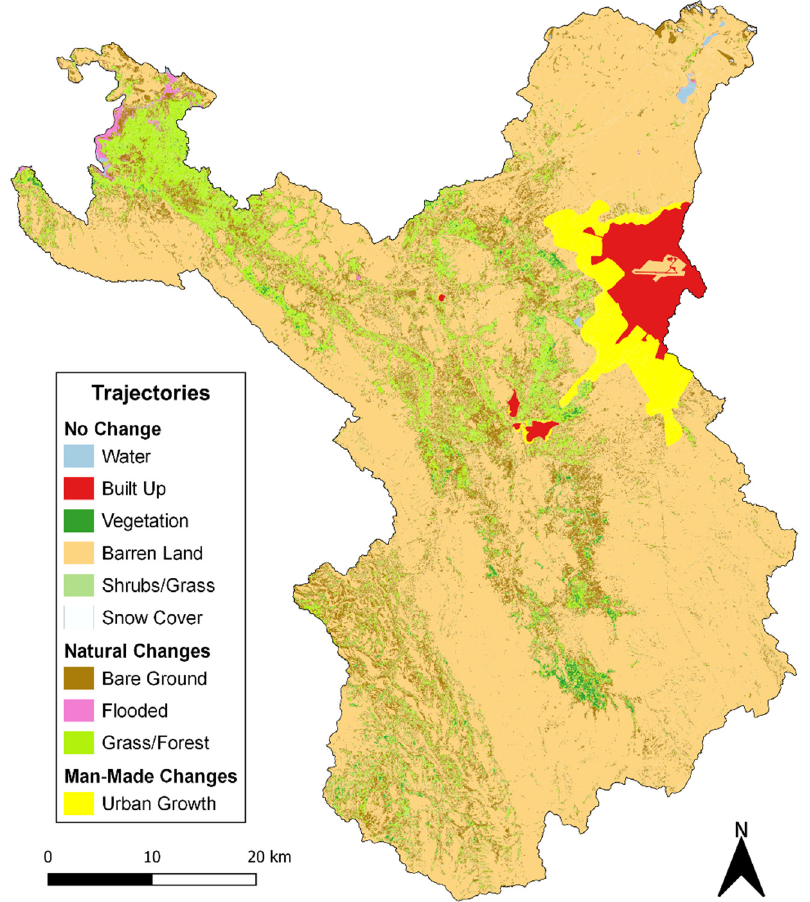
Figure 3. Trajectory map of the Katari River Basin from 2006 to 2018. Similarly, it can be confirmed that the major changes identified in the natural variability category are those of grass/forest, with a total of 386 trajectories that account for 10% of the basin area. This trajectory is also linked to the increasing trend detected for the built-up land cover throughout the study